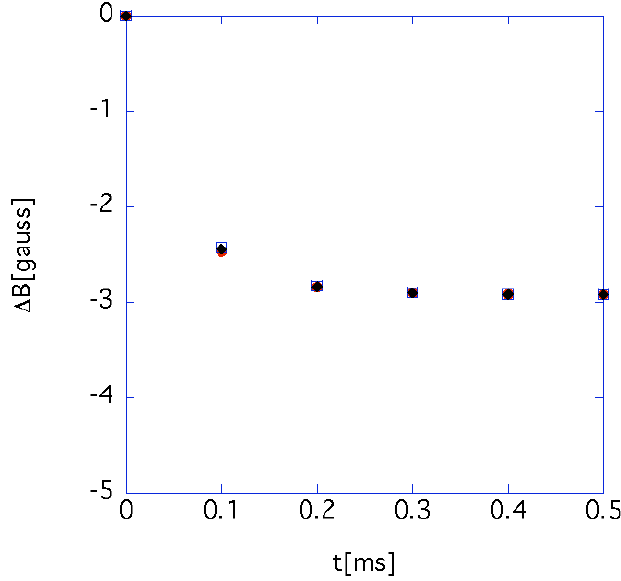
FIG. 11. (Color) The field modulation at the center of the chamber. The red, blue, and black points describe the results where the mesh size was 0.1, 0.05, and 0.025 ms, respectively.